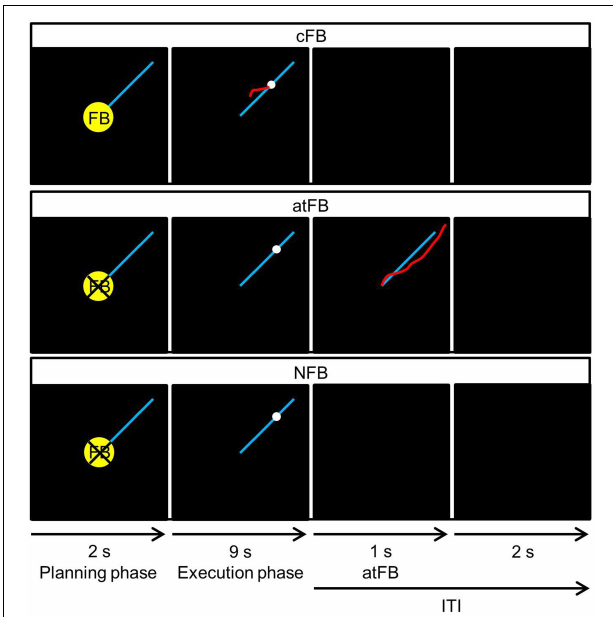
FIGURE 2 | Three types of FB conditions. Concurrent visual feedback, provided by a red cursor indicative of subjects’ current position, was only provided in the concurrent visual feedback (cFB) condition. In the after-trial feedback (atFB) condition, a motionless representation of the produced red line was provided after the execution phase while no concurrent feedback was provided during the execution phase. In the no feedback (NFB) condition, no concurrent or after-trial feedback was provided. Every trial started with a planning phase of 2s where a yellow cue, which indicated whether cFB would be given in the upcoming trial, was presented. During the execution phase, the white target dot moved with constant speed along the blue target line for 9s. In each condition, the inter-trial interval (ITI), i.e., the time between each trial where no movement was required, lasted 3s. During ITI, atFB was provided for 1s in the atFB condition. Instead, a black screen was presented in the cFB and NFB condition (Pauwels et al.,